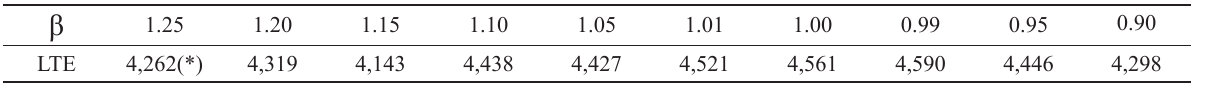
Table 6. Record solution obtained considering different values of the economic relaxation